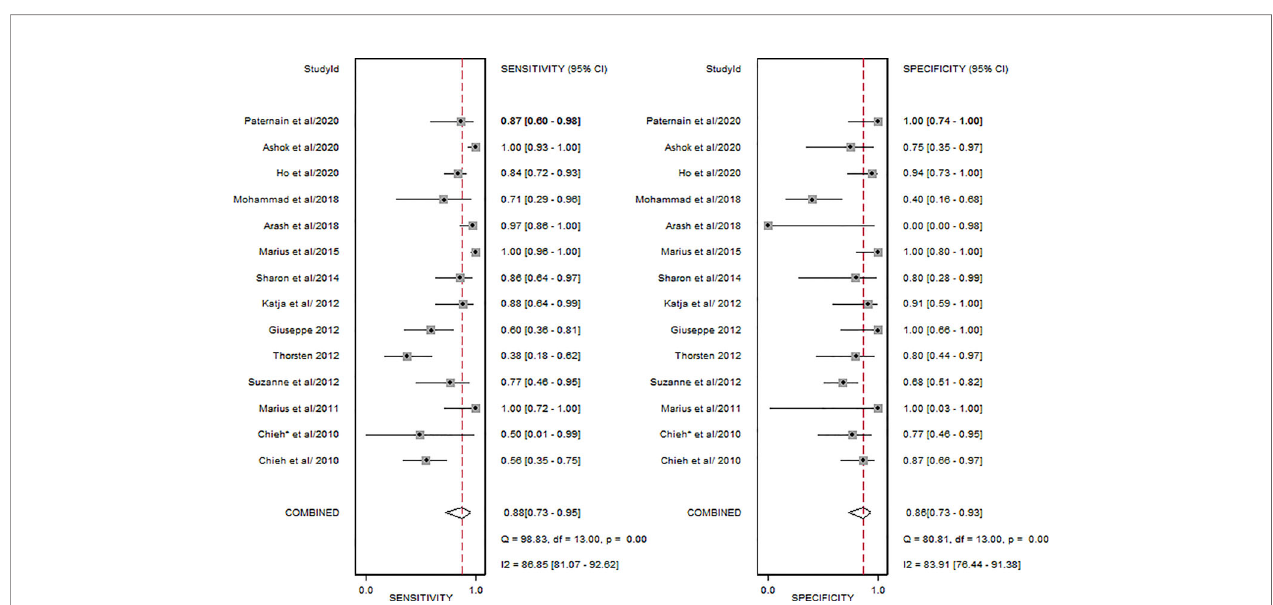
FIGURE 4 | Forest plot of the pooled sensitivity and speci fi city of the included